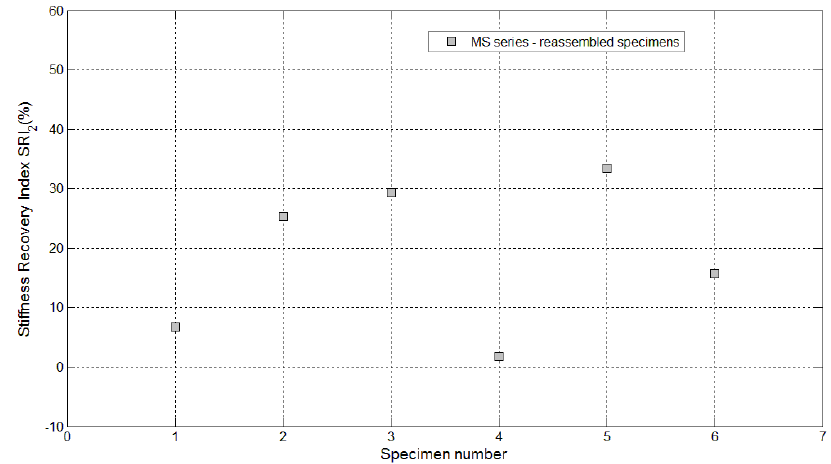
Figure 21. Stiffness recovery indices SRI 2 for specimens with maccheroni